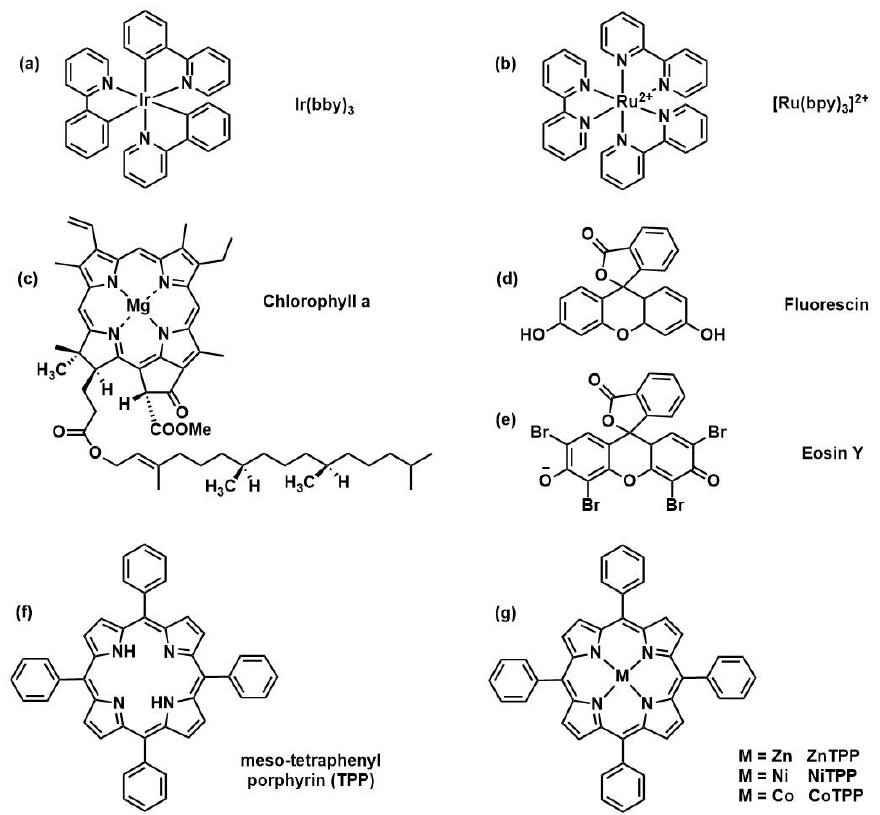
Figure 4. Selection of catalyst structures: (Ir(ppy) 3 ) [23], (Ru(bpy) 3 Cl 2 ) [30], chlorophyll a [31], Fluorescine [32], Eosine Y [32], and (metallo)porphyrin-based structures [33]. Porphyrins and metalloporphyrins are important functional molecules with a large, conjugated ring structure and typically strong absorbance in the visible region of the elec- tromagnetic spectrum and they exist in nature in the form of chlorophyll, heme, and VB 12 . Chlorophyll a (Chl a ) [31] was the first porphyrin-based structure analyzed as photocata- lysts and it was able to activate PET-RAFT polymerization. Shortly after also bacteriochlo- rophyll a (BChl a ) [34] was investigated thanks to its strong absorption at long wave- lengths from red to near-infrared (NIR) allowing to use of less energetic radiation with deep light penetration. Those initial works on chlorophyll paved the way to studies on a variety of non-toxic and low-cost metalloporphyrins with non-precious metals (Figure 4g). Zinc porphyrins [33] (in particular, 5,10,15,20-tetraphenyl-21H,23H-porphine zinc (ZnTPP)) were able to selectively activate photoinduced electron transfer-RAFT polymer- ization of trithiocarbonate compounds for the polymerization of styrene, (meth)acrylates and (meth)acrylamides under a broad range of wavelengths (from 435 to 655 nm). This photoredox catalyst has some advantages over the transition metal complexes above men- tioned such as a lower inhibition period in presence of oxygen, likely due to a specific interaction between Zn and trithiocarbonate sulfur atoms as it happens in nature, and light absorbance at lower energy. Also, metal-free porphyrin (tetraphenylporphyrin (TPP)) [35] was able to activate the polymerization but with less efficiency. For this reason, covalent conjugation with CTA was used to create acceptor-donor molecules in which TPP acted as a light-harvesting antenna donating the excited electron to the electron-ac- cepting thiocarbonylthio group. The proximity of reaction centers increasing the efficiency of electron transfer. Organic dyes provide another metal-free option for PET-RAFT